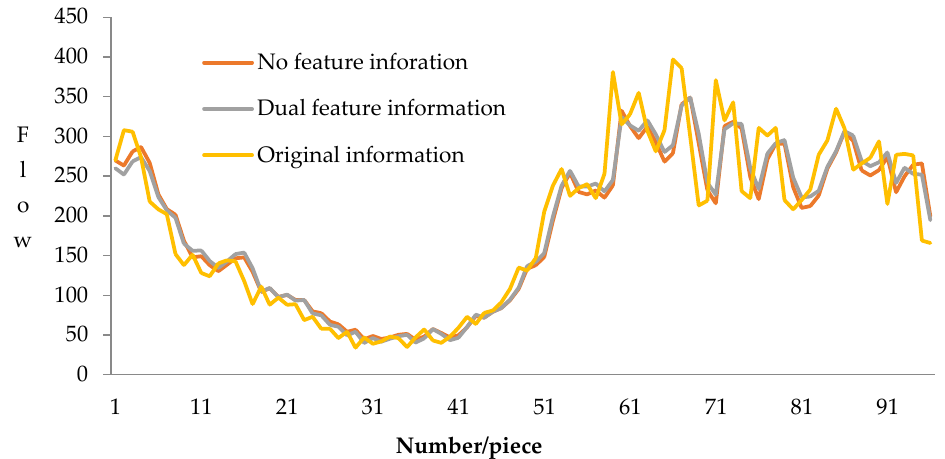
Figure 10. The decision tree feature-analysis diagram.